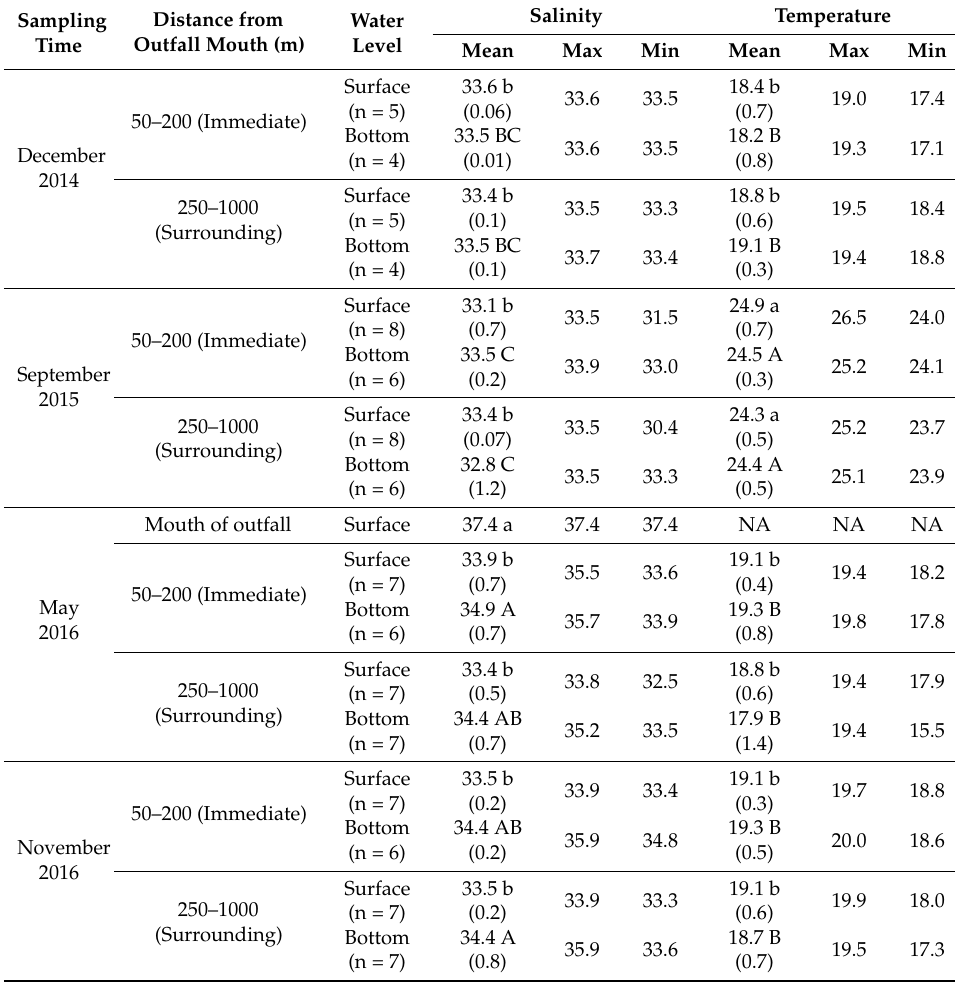
Table 1. Mean, maximum and minimum salinity and temperature ( ± S.D.), for surface and bottom water in the area immediately around the outfall mouth (50–200 m) and the surrounding area (250–1000 m) measured at the four sampling times. Post-hoc results (Tukey-HSD, p < 0.05) for mean salinity and temperature are indicated in small letters for surface water and capital letters for bottom water behind each mean value.